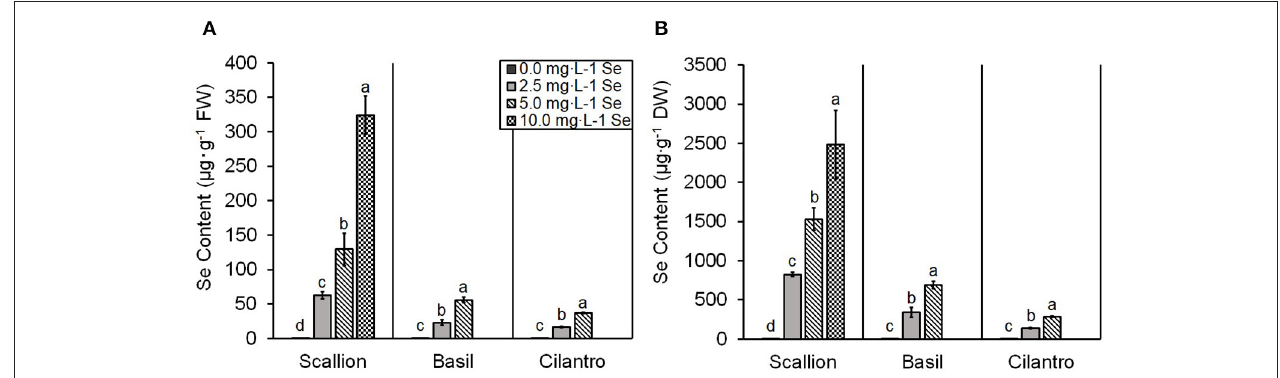
FIGURE 1 | Selenium (Se) content of scallion ( Allium fistulosum L.), basil ( Ocimum basilicum L.), and cilantro ( Coriandrum sativum L.) microgreens treated with various concentrations of Se as sodium selenate, on (A) fresh weight (FW) basis and (B) dry weight (DW) basis. Bars indicate mean ± standard deviation (SD) for three replicates ( n = 3) of each plant species. The Tukey’s significance at P ≤ 0.05 among Se treatments is indicated by different letters within the plant species.